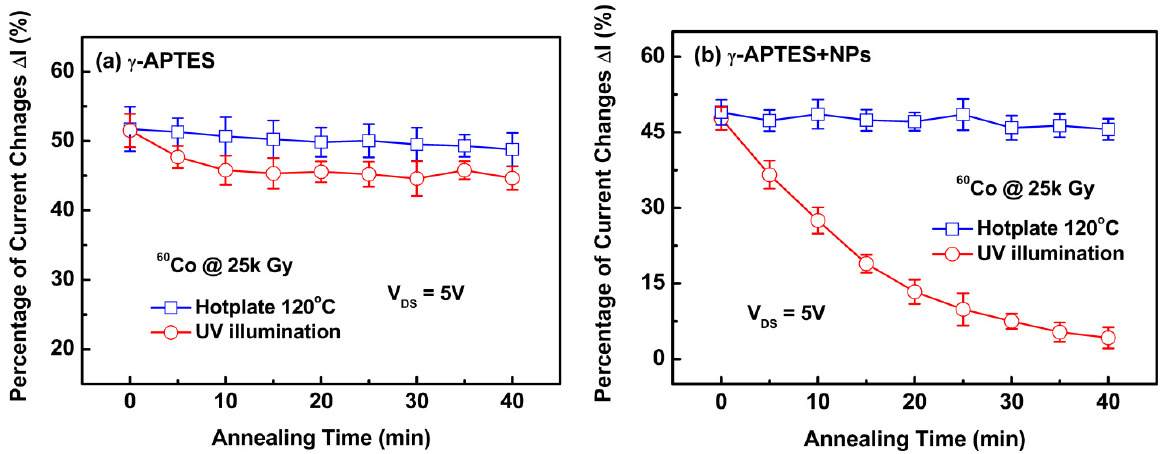
Figure 6. Percentage of current change Δ I time curves after 25 kGy γ -ray irradiation for the (a) γ -APTES/native-oxide/PSW and (b) γ -APTES+NPs/native-oxide/PSW